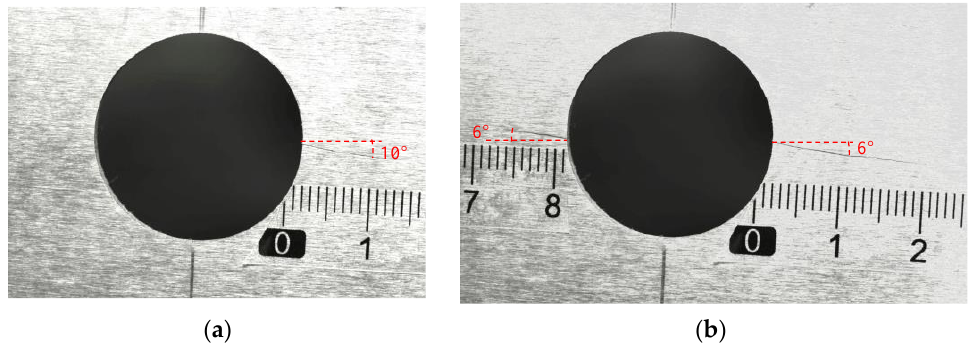
Figure 7. Experimental setup for center-hole metal specimens.